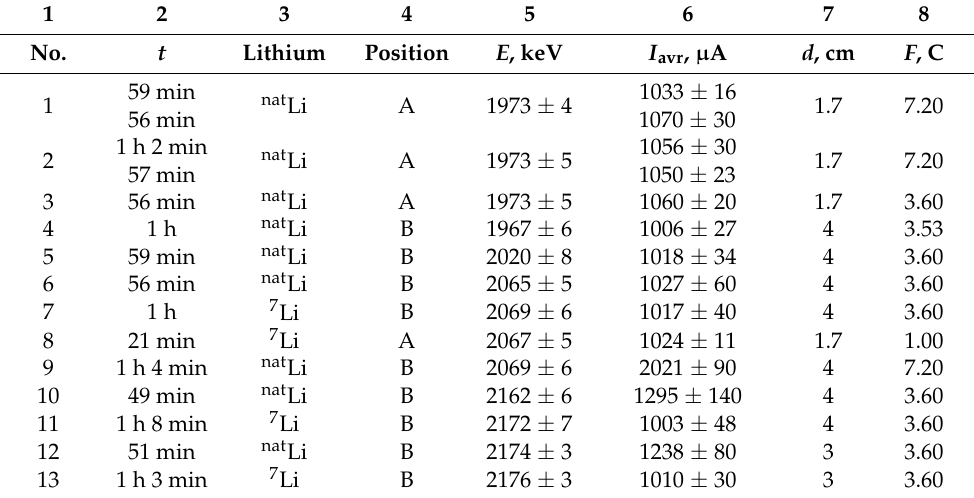
Table 1. Data on irradiation sessions. Columns: 1—serial number of targets; 2—neutron generation duration t ; —type of lithium used (natural or enriched with lithium-7 isotope); 4—target position A or B (see Figure 1); 5—proton energy E ; 6—average current I ; 7—approximate size of the proton beam on the surface of the lithium target d ; 8—collected proton fluence F measured with the Faraday